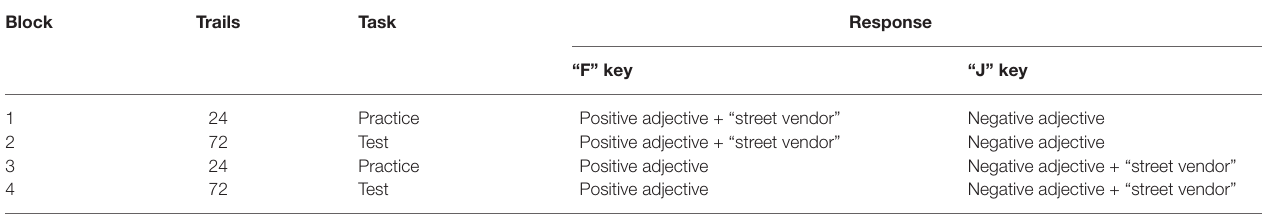
TABLE 2 | The procedure of “SC-IAT.” Block Trails